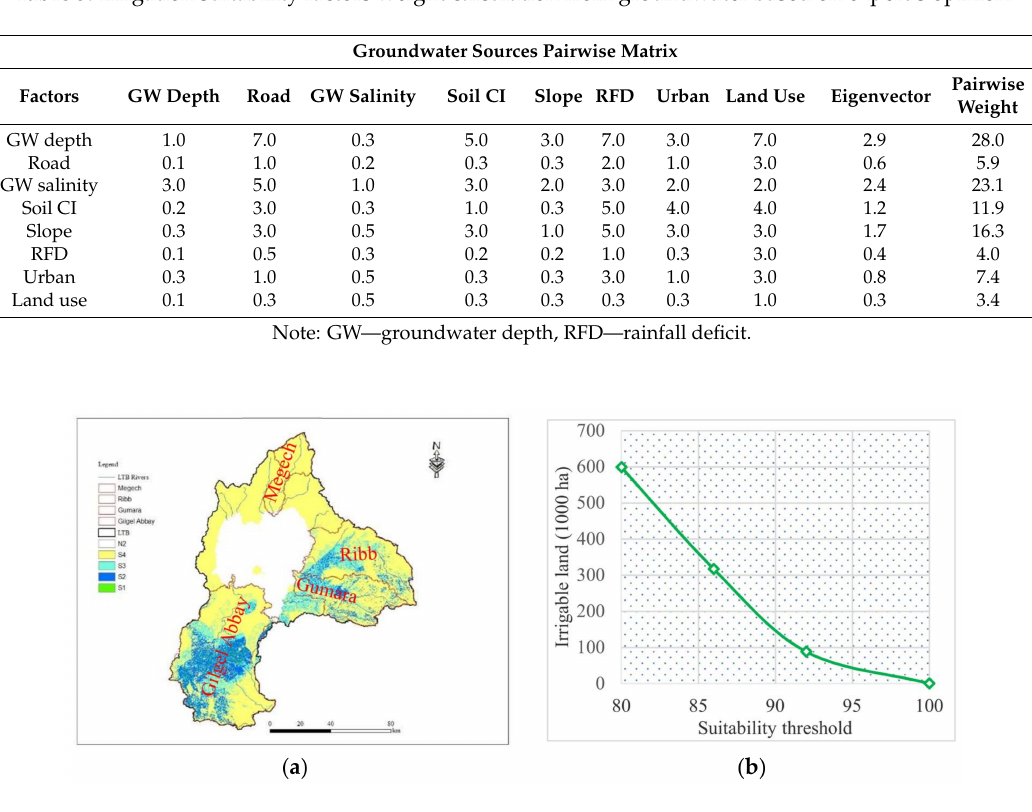
Table 5. Irrigation suitability factors weight calculation from groundwater based on expert’s opinion.